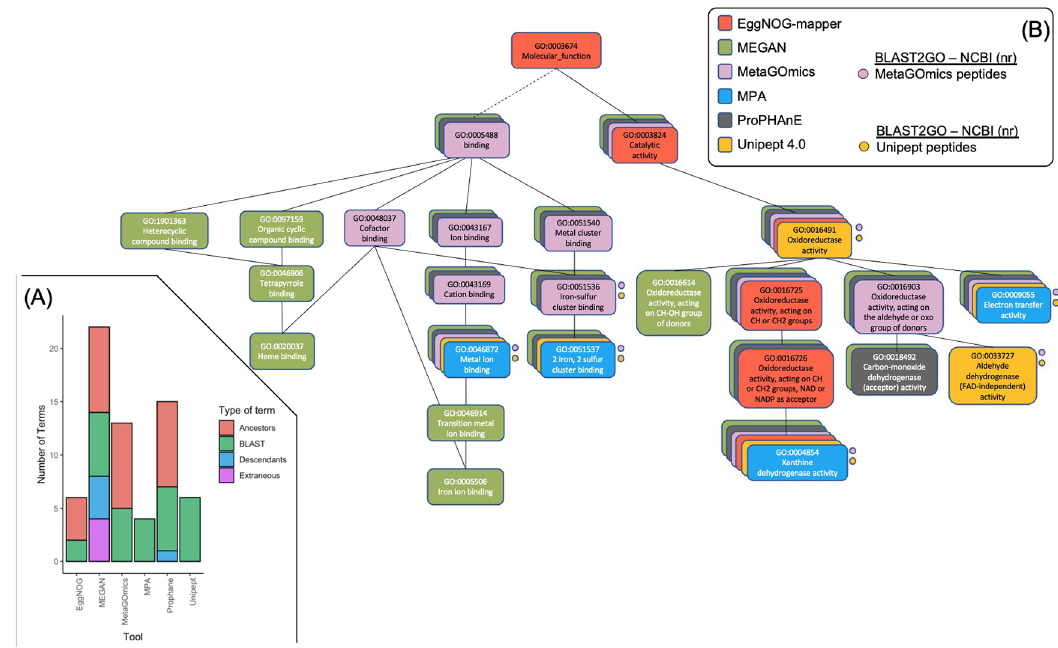
Fig 4. Gene ontology hierarchy analysis of a single GO term for all six tools. A) A stacked bar chart representation of the related terms (descendants, ancestors, ancestor’s children, or extraneous) for xanthine dehydrogenase activity (XDA) for all six functional tools. Colors correspond to these relation types. Green represents terms that were found through BLAST2GO’s annotation via NCBI (nr). The other colors represent the relationship of the other terms in other tools to those BLAST GO terms. These types are quantified and stacked on one another to show the contributions of each relationship type to the overall GO hierarchy. B) A single GO hierarchy analysis of xanthine dehydrogenase activity (XDA) (GO:0004854) for all six functional tools. For each tool, the GO terms of annotation groups containing XDA are arranged in a GO hierarchy for each tool. Each GO term is contained in a rounded rectangle. All six hierarchies are layered upon one another (with the largest in the background and the smallest in the foreground). Each color represents a tool (not a GO relationship). Solid lines represent “is a” or parent/child relationships and the dashed line indicates a connection that is present in the overall combined hierarchy, but not in any of the individual hierarchies. Circles indicate GO terms derived from BLAST2GO—NCBI (nr) results using peptides from the peptide-level tools (MetaGOmics, Unipept, EggNOG-mapper). GO terms not represented by more than one peptide are omitted (hence why eggNOG-mapper is not represented